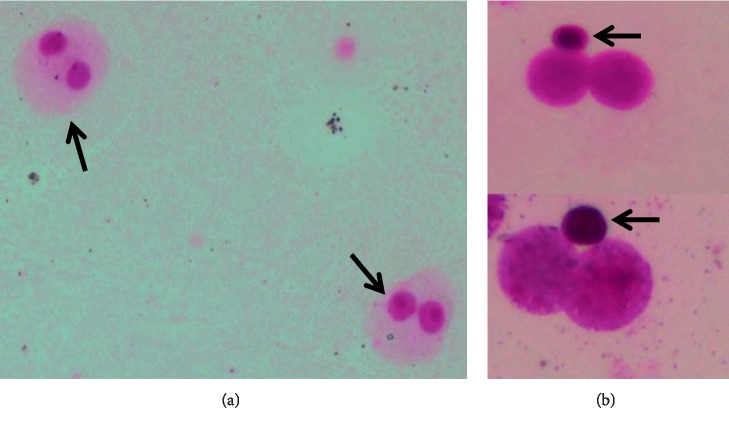
Representative of images of cells scored in the micronucleus study: (a) normal binucleated cells, shown by black arrows and (b) close-up view of binucleated cells with a micronucleus. The micronuclei are shown with black arrows.